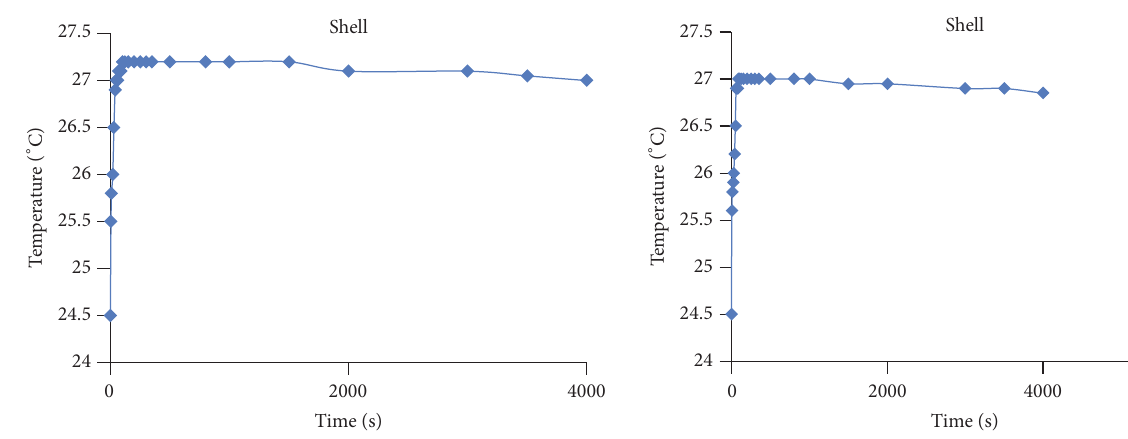
Figure 5: Variation of the water temperature of the calorimeter after the introduction of the hot shell.